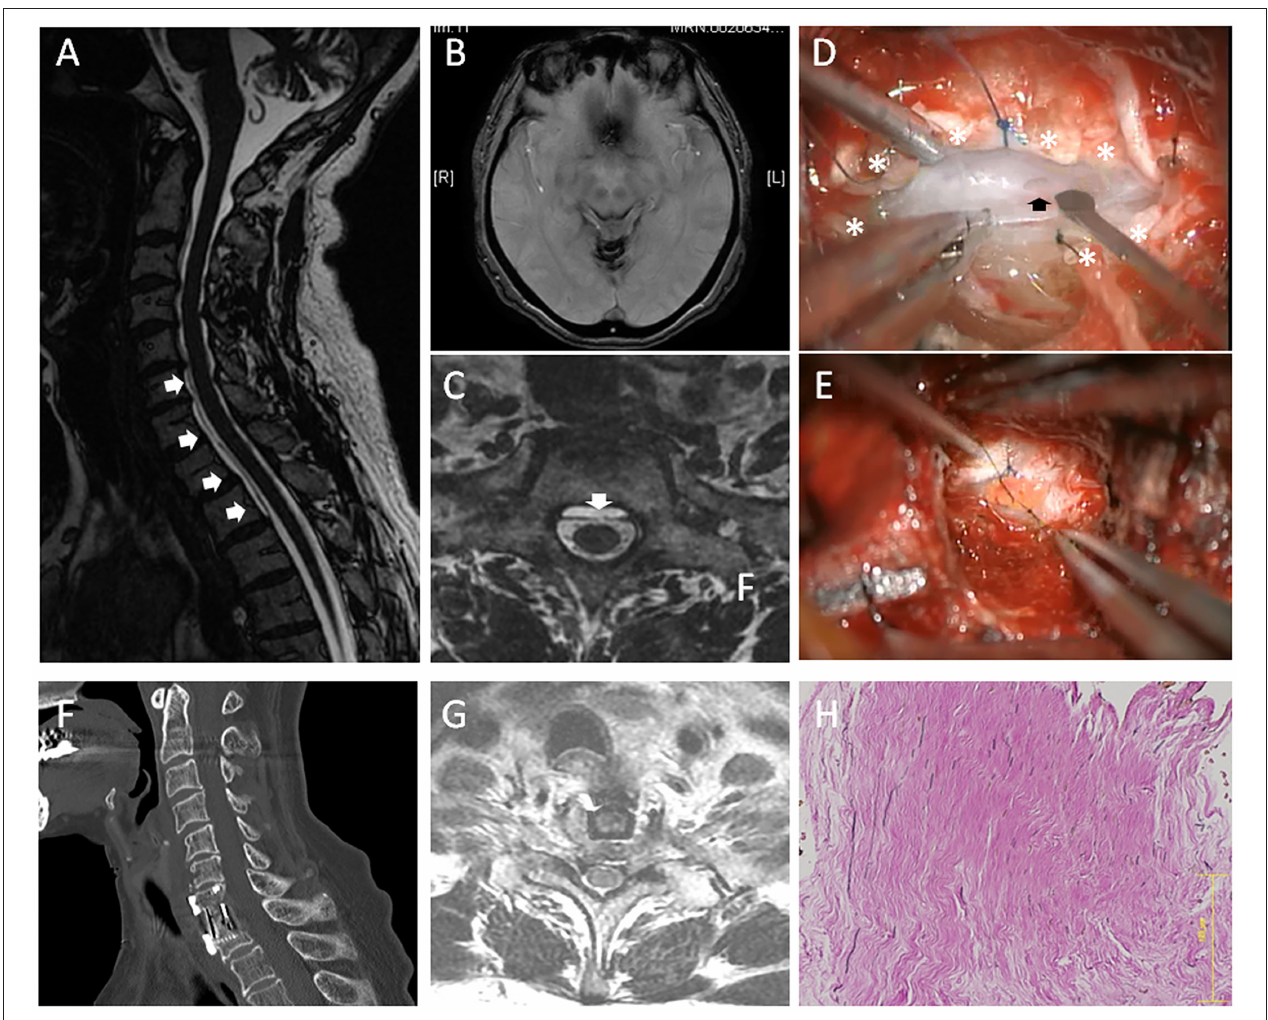
FIGURE 2 | A 69-year-old female (case 2). (A) Sagittal MRI showed VFCC from C3 to T2 in the spinal canal (white arrows). (B) Brain MRI showed a hemosiderin deposition in the superficial brain. (C) An axial FIESTA image demonstrated that a dural defect was located at the C7-T1 level (the white arrow). (D) An intraoperative picture of anterior approach (case 2): After the outer dura layer (white asterisks) was excised at the center, we found a dural defect (the black arrow) in the dura mater’s inner layer. (E) Since the inner dural layer was extremely thin and fragile, the defect was repaired using a free fat graft. (F) The spine was fused using a cage and a plate. (G) Post-operative MRI showed the dural defect was repaired. (H) The histology of the outer layer (HE staining) demonstrated that rich collagen fibers were oriented in a longitudinal direction. The bar: 125 µ